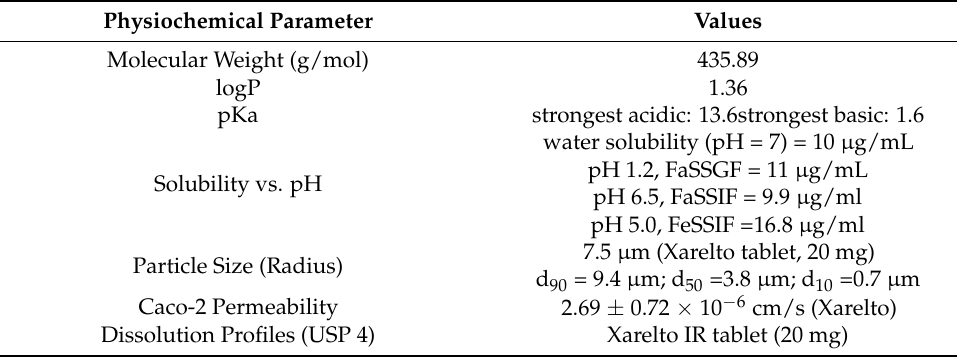
Table 1. Input parameters of Riva for building the PBPK model in GastroPlus